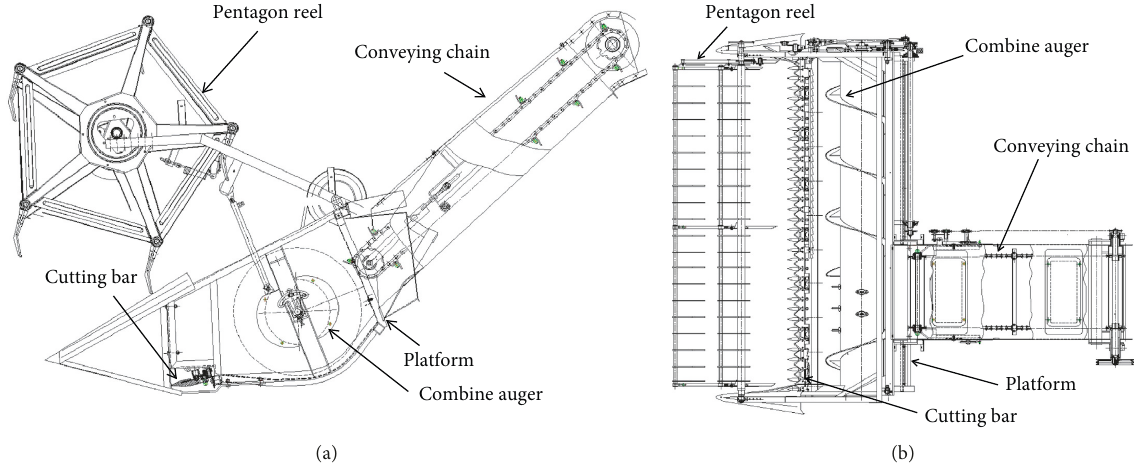
Figure 1: Structure and composition of front header. (a) Header main view. (b) Header top view.